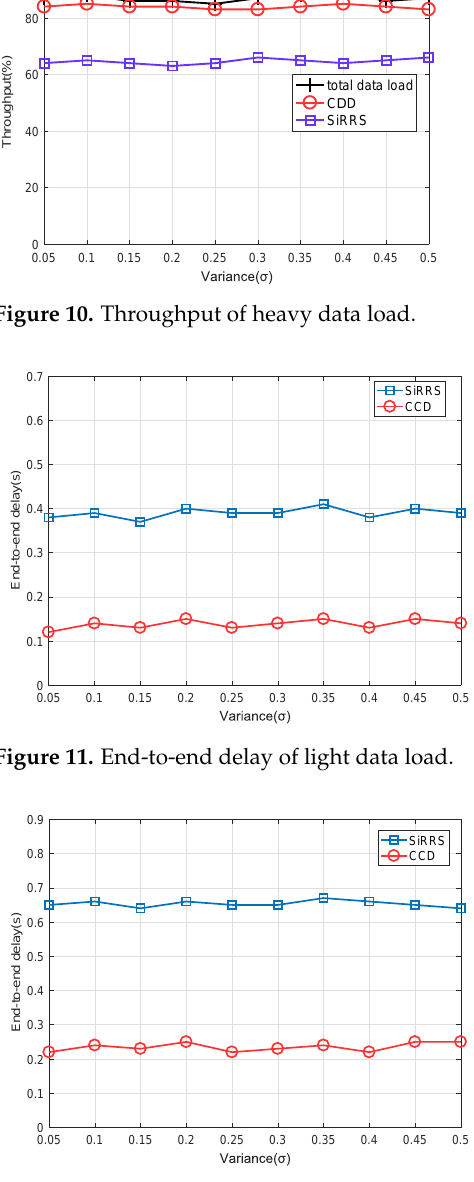
Figure 12. End-to-end delay of heavy data